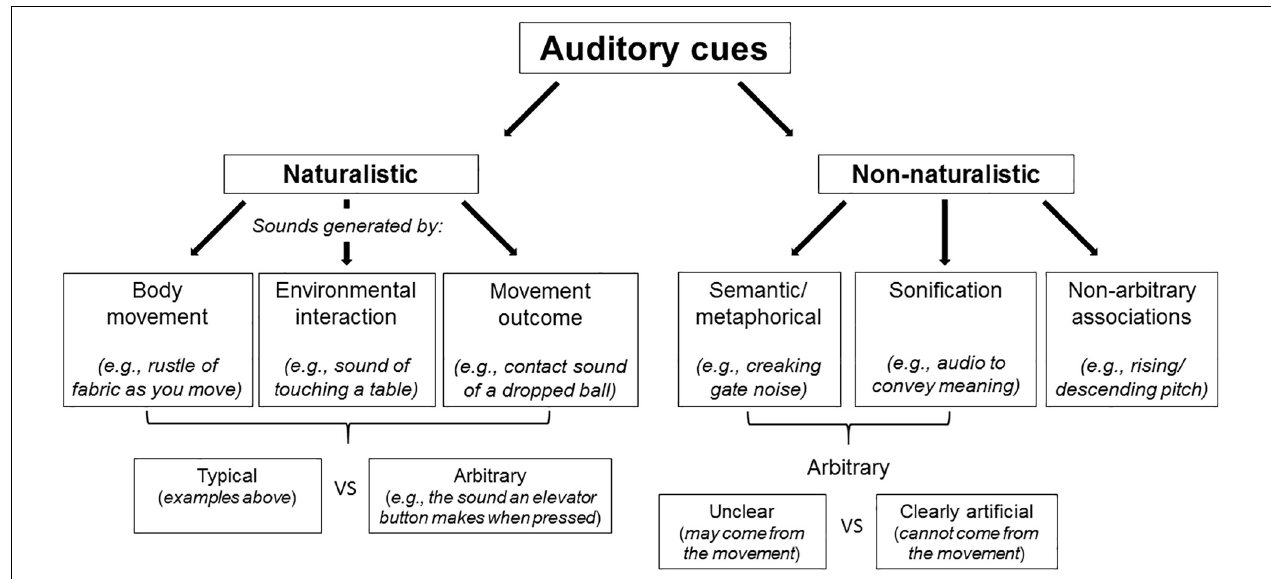
FIGURE 1 | Classification of auditory cue